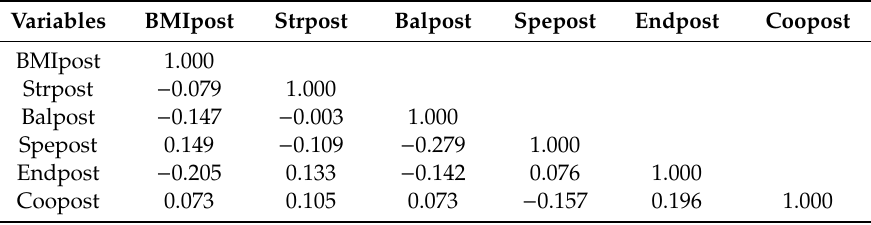
Table 4. Correlations post-intervention